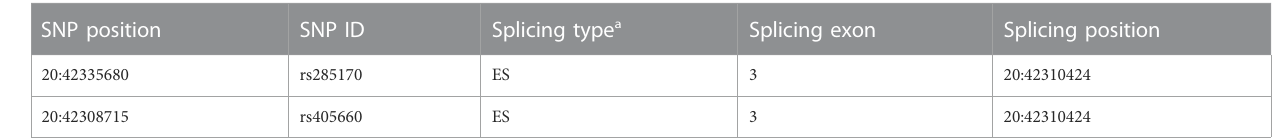
TABLE 7 Splicing function prediction of candidate